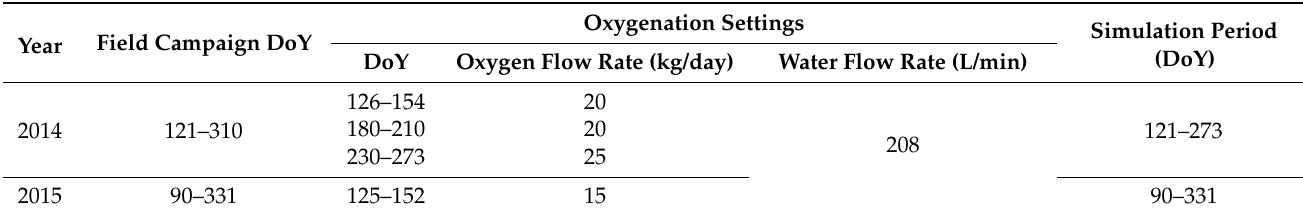
Table 1. Information about the operation of the oxygenation system in the years 2014 and 2015 and the corresponding simulation periods.